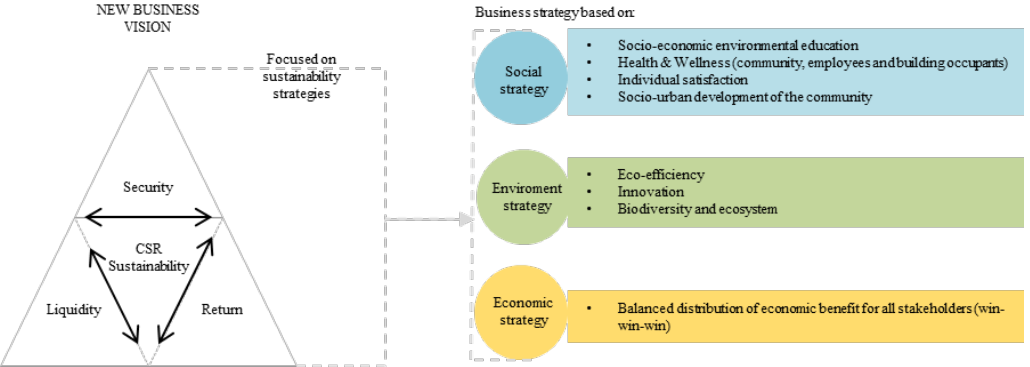
Figure 6. The new business investment vision and the main drivers of the sustainable business strategy (source: adapted from Lorenz, 2006; UNEP FI, 2014; Porter & Kramer,